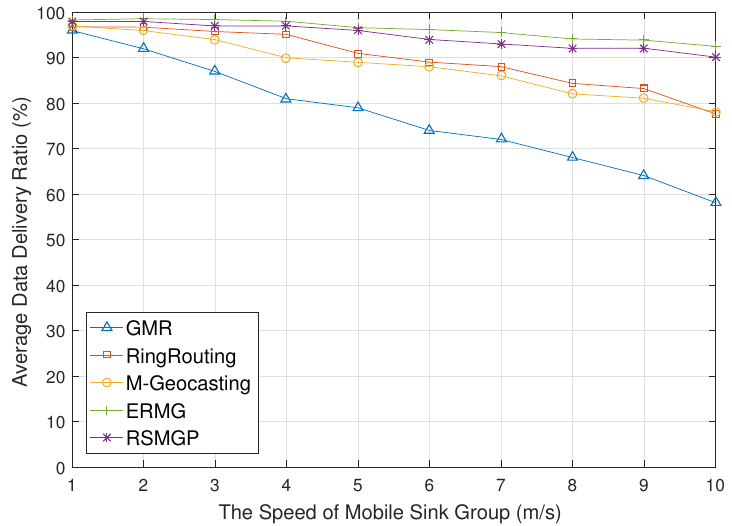
Figure 11. Data delivery ratio impacted by moving speed of a sink